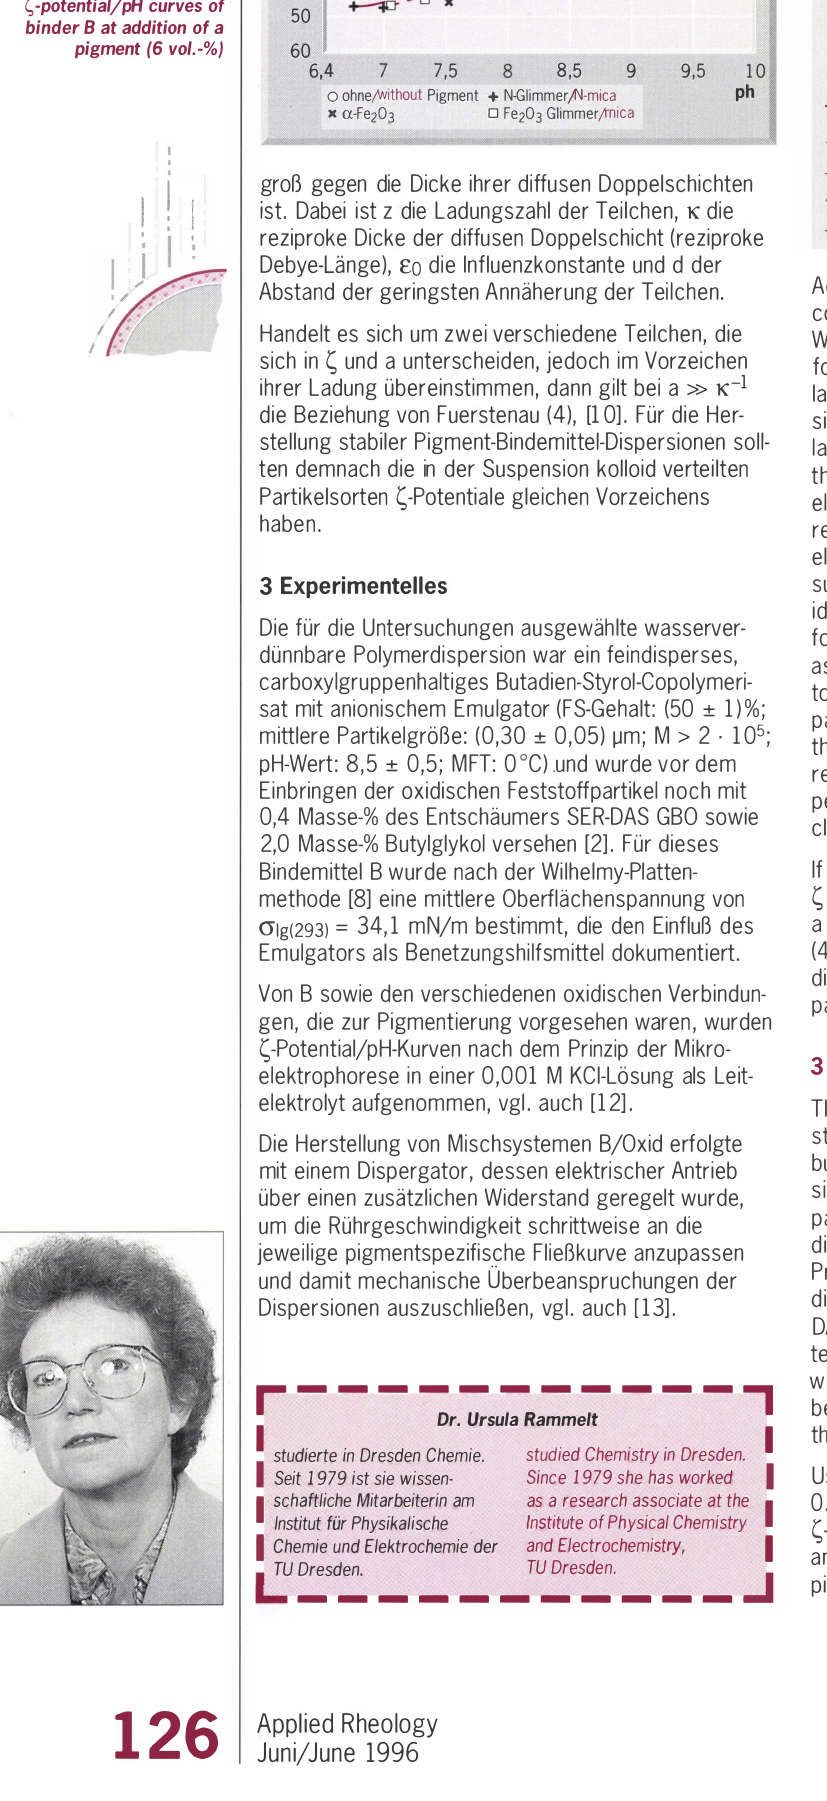
t;, -potential/pH curves of binder B at addition of a pigment (6